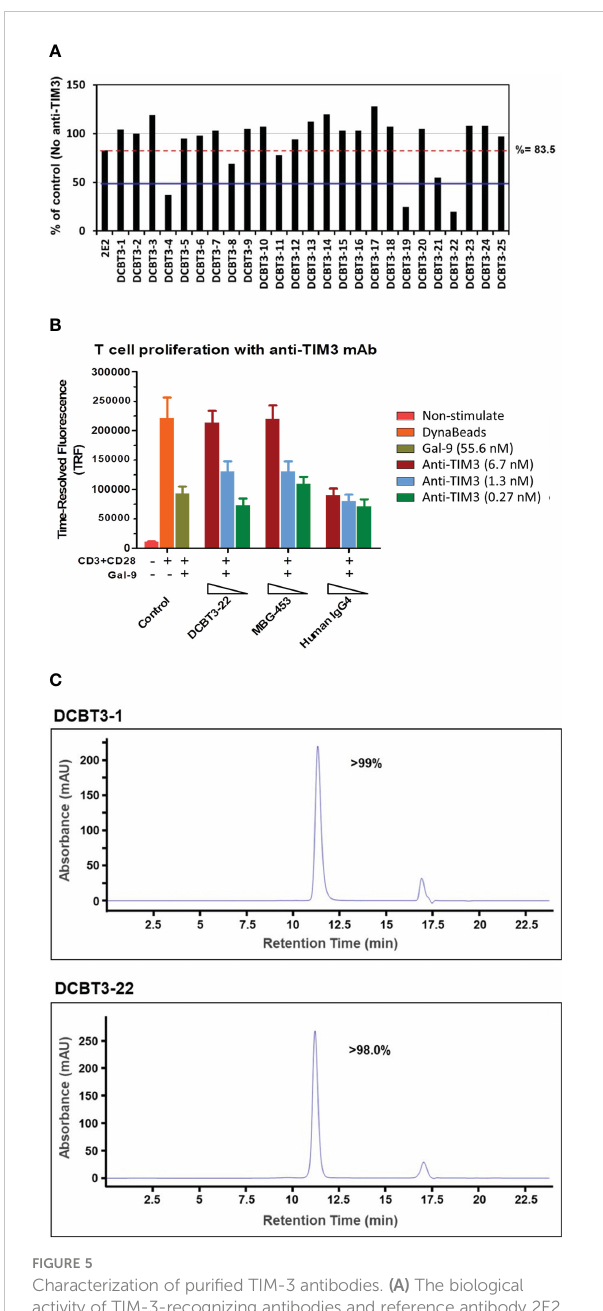
FIGURE 5 Characterization of puri fi ed TIM-3 antibodies. (A) The biological activity of TIM-3-recognizing antibodies and reference antibody 2E2 which can block the interactions between TIM-3 and it ’ s receptor in TIM-3 reporter assay at 1.11 mg/ml (7.3 nM). Red dotted line indicates the inhibition activity of reference antibody 2E2 at 7.3 nM. Blue full line indicates the 50% inhibition ratio at 7.3 nM. Percent of Control = (RLU Ab dilution/RLU no antibody control) × 100%. The inhibition ratio (%) was calculated by the formula: 100% – (RLU Ab dilution/RLU no antibody control) × 100%. (B) The biological activity of DCBT3-22 and reference antibody MBG-453 which can relieve the cell proliferation inhibitory effect of Galectin-9 ligand. No antibody treatment groups are as control. (C) SEC-HPLC results of puri fi ed TIM-3 antibodies. Analytical size-exclusion chromatogram of puri fi ed TIM-3